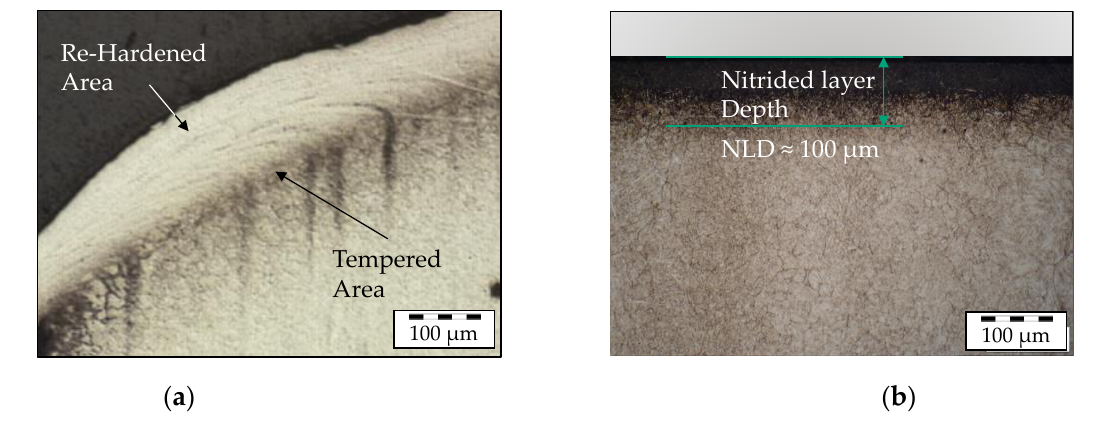
Figure 3. ( a ) Re-hardening and tempering effects in the tool surface layer of a forging tool; ( b ) Nitrided layer of forging tool.